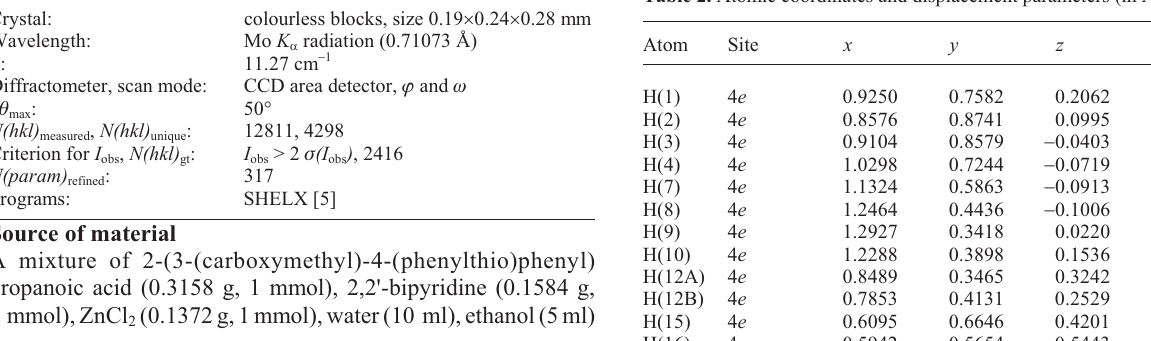
Table 2. Atomic coordinates and displacement parameters (in Å 2 )